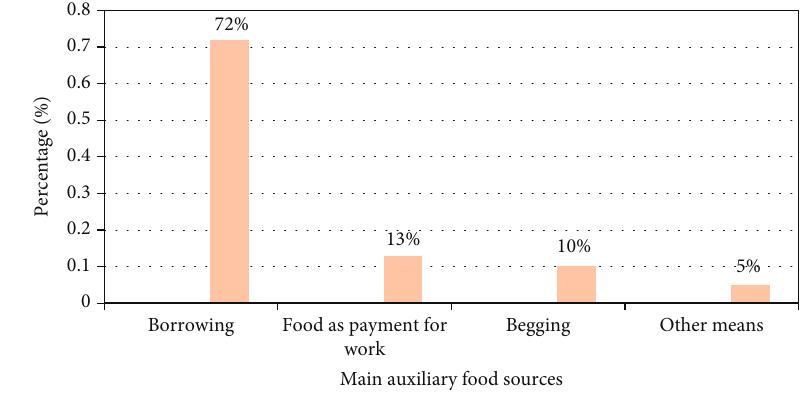
Figure 2: Main auxiliary food sources.